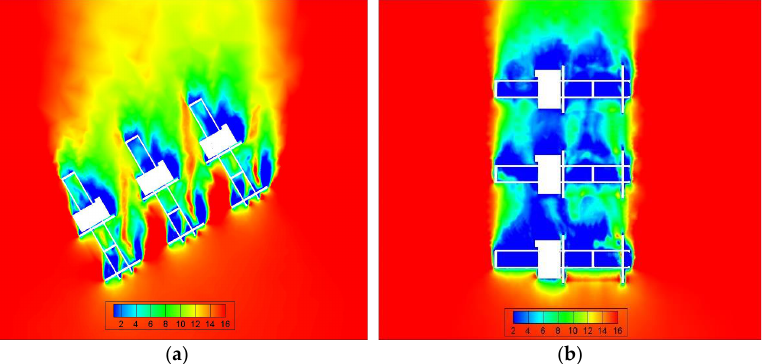
Figure 15. Contour plots of the horizontal wind velocity at the height of the jib of boom-down crane (h = 57m): ( a ) α = 30°; and ( b ) α = 90°.